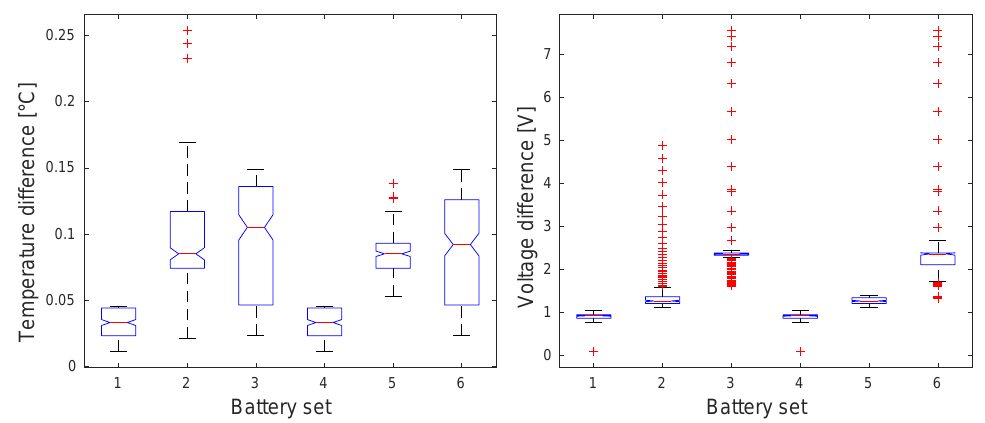
Figure 6. The analysis of variance of temperature ( left ) and voltage ( right ) ranges during the charging period.